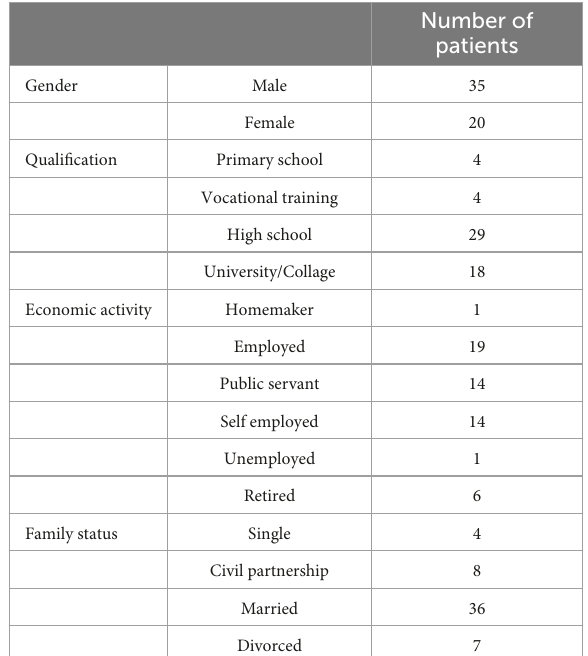
TABLE 1 Demographic characteristic of the